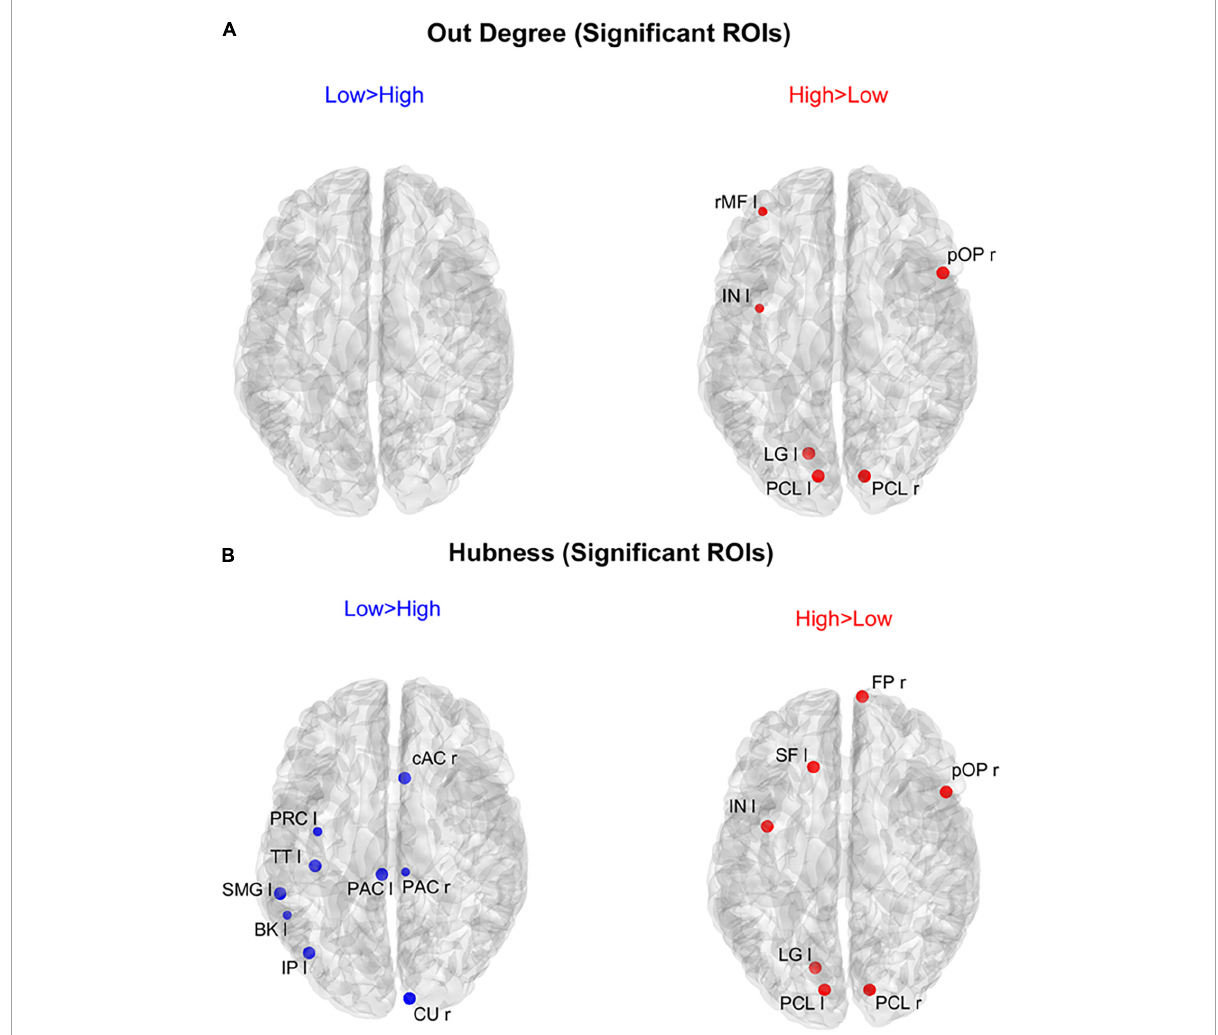
FIGURE8 Positions of the ROIs which exhibited a significant difference in the out degree index [upper panels (A) ] or in the hubness index [lower panels (B) ] between the two groups ( p -value < 0.05, Bonferroni corrected). The left panels in blue (Low > High) display the ROIs having significantly higher centrality index in the Low AQ score Group compared to the High AQ score Group. The right panels in red (High > Low) display the ROIs having significantly higher centrality index in the High AQ score Group compared to the Low AQ score Group. The significant ROIs are shown as simple dots and represent regions from which important information originates. Three levels of dots’ size have been adopted: the larger the dot size, the more significant the centrality difference. For the panels where no dot appears over the brain map (i.e., out degree for Low > High), the constraint of significance was not satisfied by any of the 68